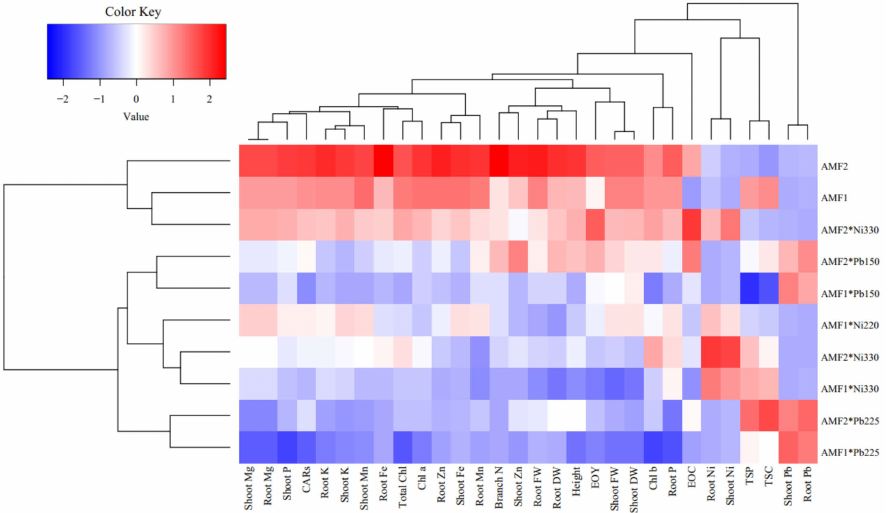
Figure 7. Heat map and cluster analysis of the growth parameters, macro- and micronutrient contents, and some biochemical changes in lavender plants exposed to HM stress and AMF inoculation. The heat map represents the shoot and root P, K, Mg, Fe, Zn, and Mn contents, branch number, plant height, essential oil content (EOC), essential oil yield (EOY), total soluble carbohydrate (TSC) content, total soluble protein (TSP) content, and the shoot and root Pb and Ni